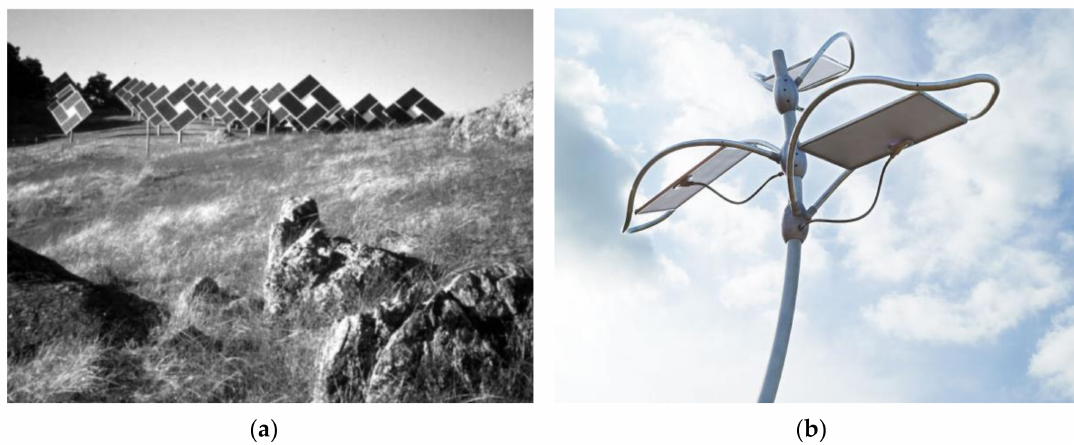
Figure 1. Examples of PV panels applied in urban structures: ( a ) Solar electric sunflowers resemble nature itself. The combination of art and technology at the top of the hillside in Northern California